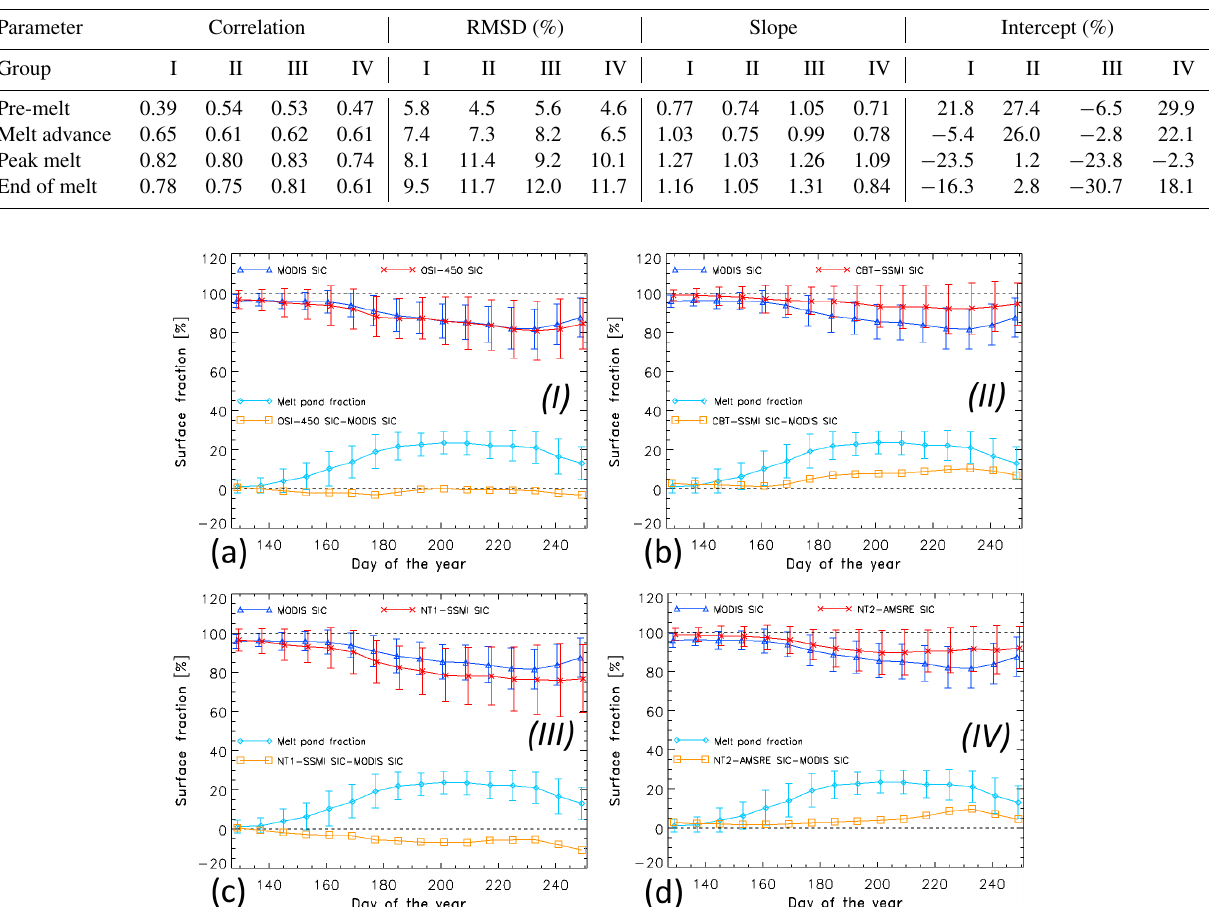
Table 3. Average values of linear correlation, root-mean-squared difference (RMSD), and slope as well as intercept of the linear regression between passive microwave and MODIS sea-ice concentration for product groups I to IV (see text for further information). The averages are derived as the arithmetic mean from all 8d period values of products within one group falling into pre-melt: DOY 129, 137, and 145, melt advance: DOY 153 to 185, peak melt: DOY 193 to 233, and end of melt: DOY 241 and 249.